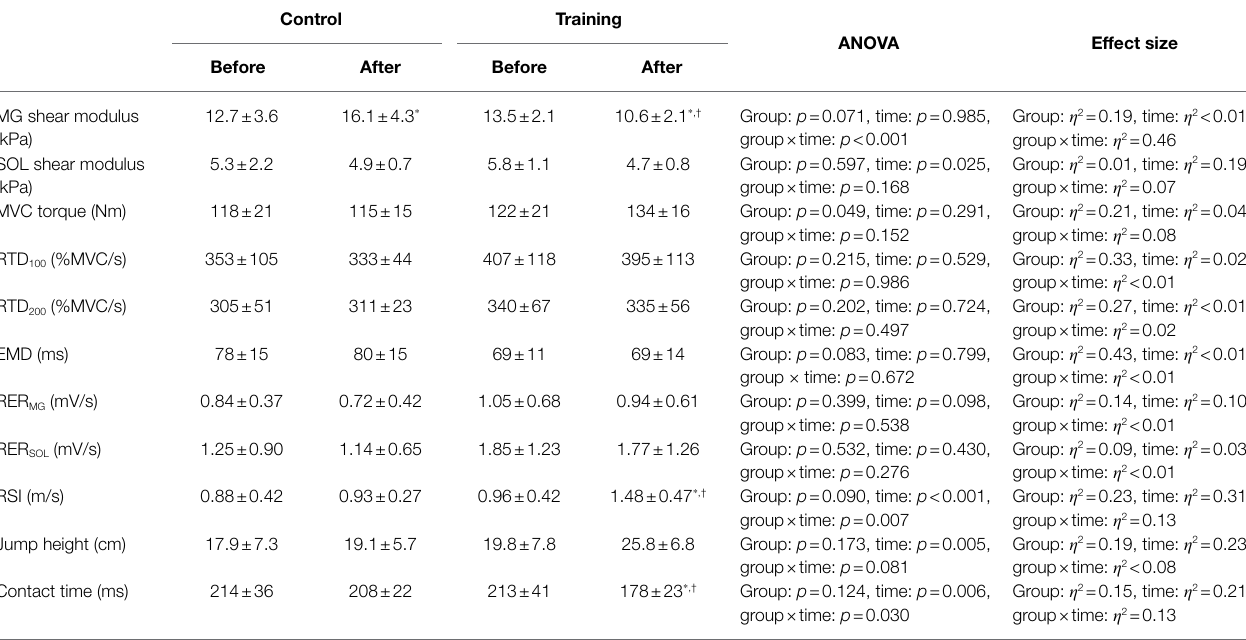
TABLE 1 | Shear modulus, MVC torque, RTD, EMD, RER, RSI, jump height, and contact time for control and training groups.